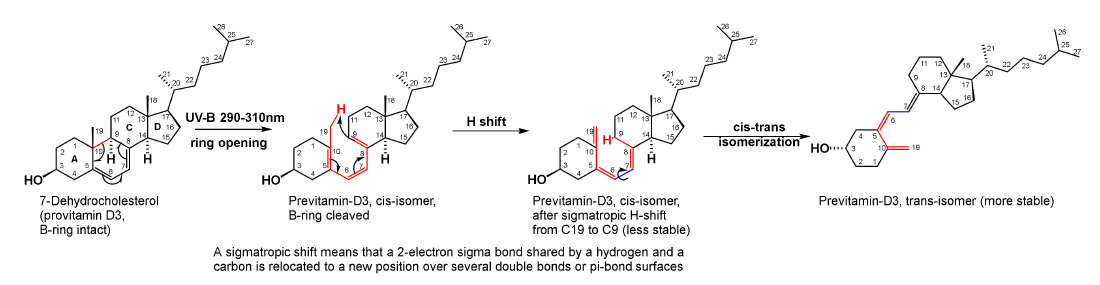
Figure 8. Conversion of Pro-vitamins-D to Pre-vitamins-D. Conversion of a pro-vitamin D to a pre-vitamin D involves opening of the B-ring, a sigmatropic hydrogen shift from C-19 to C9, and a cis to trans isomerization. The latter isomer is more stable